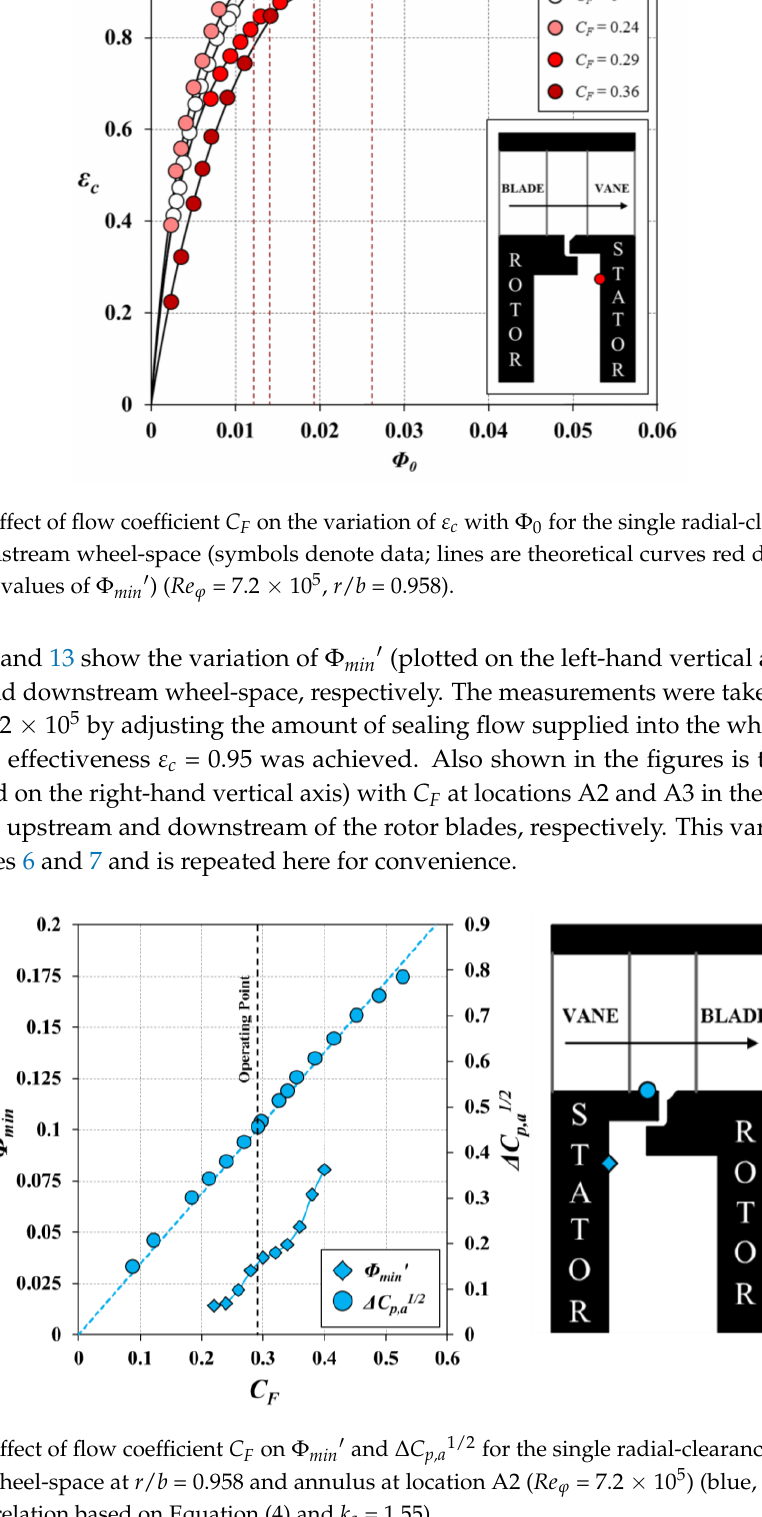
Figure 13. Effect of flow coefficient C F on Φ min ’ and Δ C p,a 1/2 for the single radial-clearance seal in the downstream wheel-space at r / b = 0.958 and annulus at location A3 ( Re φ = 7.2 × 10 5 ). Consider, firstly, the measurements shown in Figure 12. Both Φ min ’ and Δ C p,a 1/2 increase linearly with C F , indicating EI ingress in agreement with the theoretical orifice model of Owen [1]. Now, consider Figure 13: in the downstream wheel-space, both Φ min ’ and Δ C p,a 1/2 reach a minimum near the operating point and increase for flow coefficients either side of this value. For C F , which is larger than the operating point, the linear behaviour between Φ min ’ and Δ C p,a 1/2 returns, showing that ingress in the downstream wheel-space is influenced by the vane pressure field immediately downstream of the seal clearance.